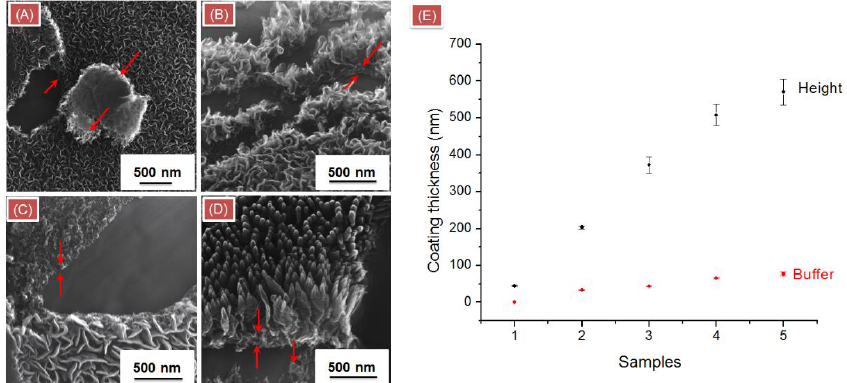
Figure A3. ( A – D ) Representative FE-SEM images of VOG coatings prepared on the copper foil substrate at deposition time: 1 min ( A ), 5 min ( B ), 15 min ( C ) and 30 min ( D ), and heating treatment: 40 min at 450 ◦ C at 2/5 partial pressure of propane in {C 3 H 8 + Ar} gas mixture. Red arrows point to the presence of a bottom buffer layer. ( E ) Calculated values of the overall height of a VOG coating and its buffer layer thickness obtained from the FE-SEM images. In the plot, the numbers along the x axis indicate the VOG samples.